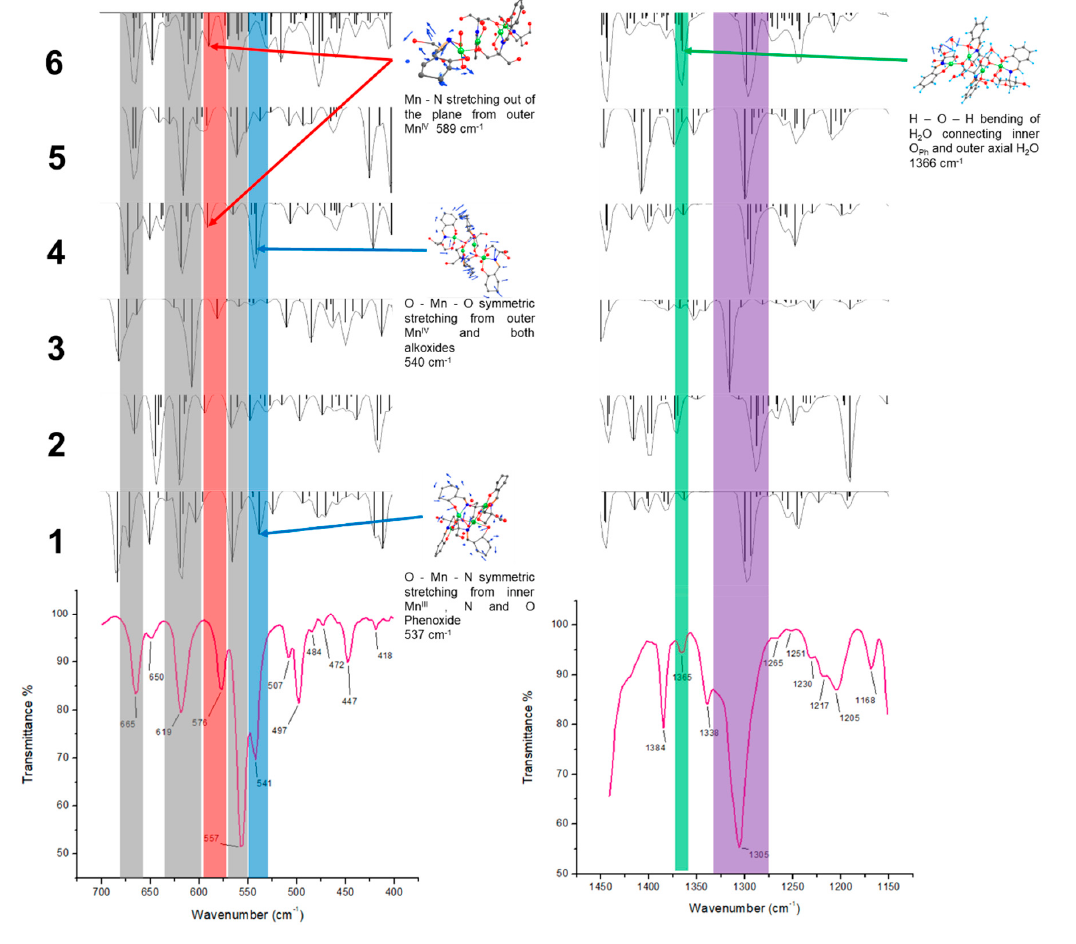
Figure 10. Comparison of experimental (bottom) and theoretical (model compounds 1-6) IR spectra. In the left is presented the region of 700 to 400 cm − 1 and in the right the region of 1450 to 1150 cm − 1 .